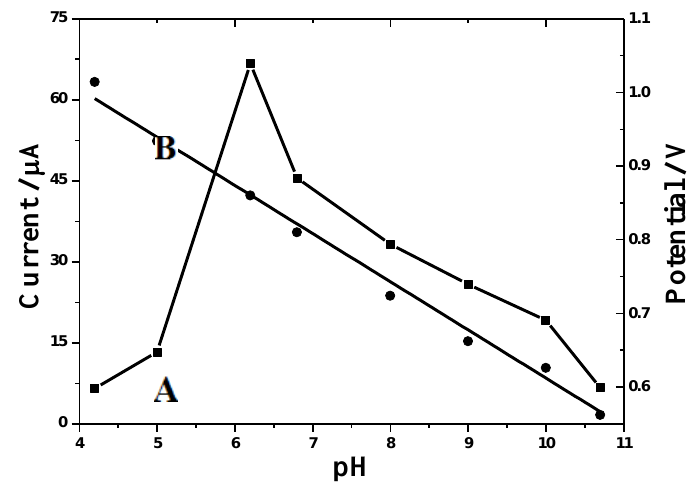
Figure 7. Influence of pH on anodic peak current (A) and peak potential (B) of doxepin. Supporting electrolyte: 0.10 M PBS. Other conditions as in Figure